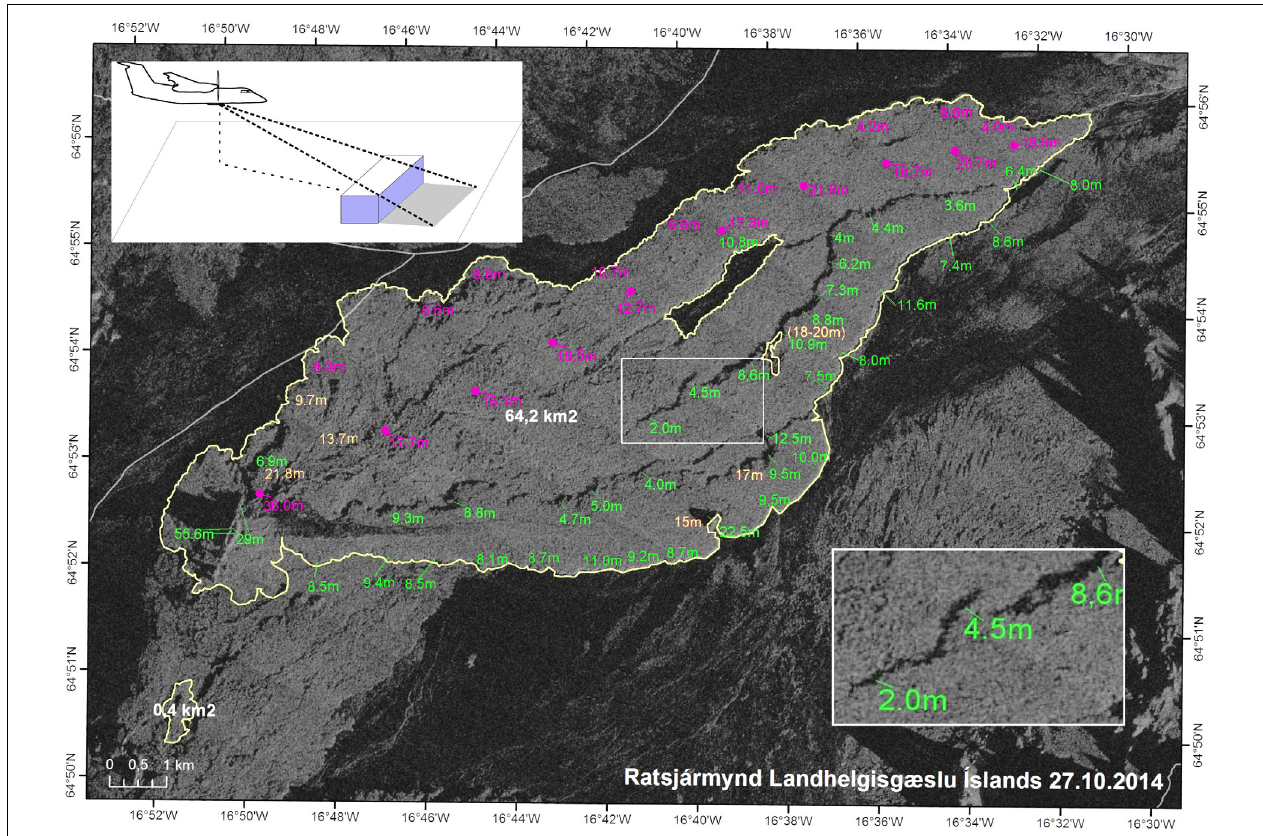
FIGURE 9 | Map generated by airborne SAR comprising thickness values assessed by airborne SAR and ground-based methods. The green numbers give the heights of visible margins, measured by aerial SAR shadow analyses (schematically drawn in upper left corner). Inlet in the lower right corner shows a close-up on exemplary shadows seen as black areas. The SAR maps used were taken on flights at October 15, 27, and 28, 2014. These numbers are relative height values of overlapping lava flow fronts. In contrast, numbers colored in orange are absolute thickness values, obtained by comparing the SAR map of October 27 with a pre-eruptive DEM (East orange values), and by theodolite measurements conducted at October 23 (South–West orange values). Magenta colored numbers represent absolute thickness values obtained from theodolite measurements conducted on September 19 and 20. Since between these dates lava flow inflation might have occurred, all given values should be regarded as minimum